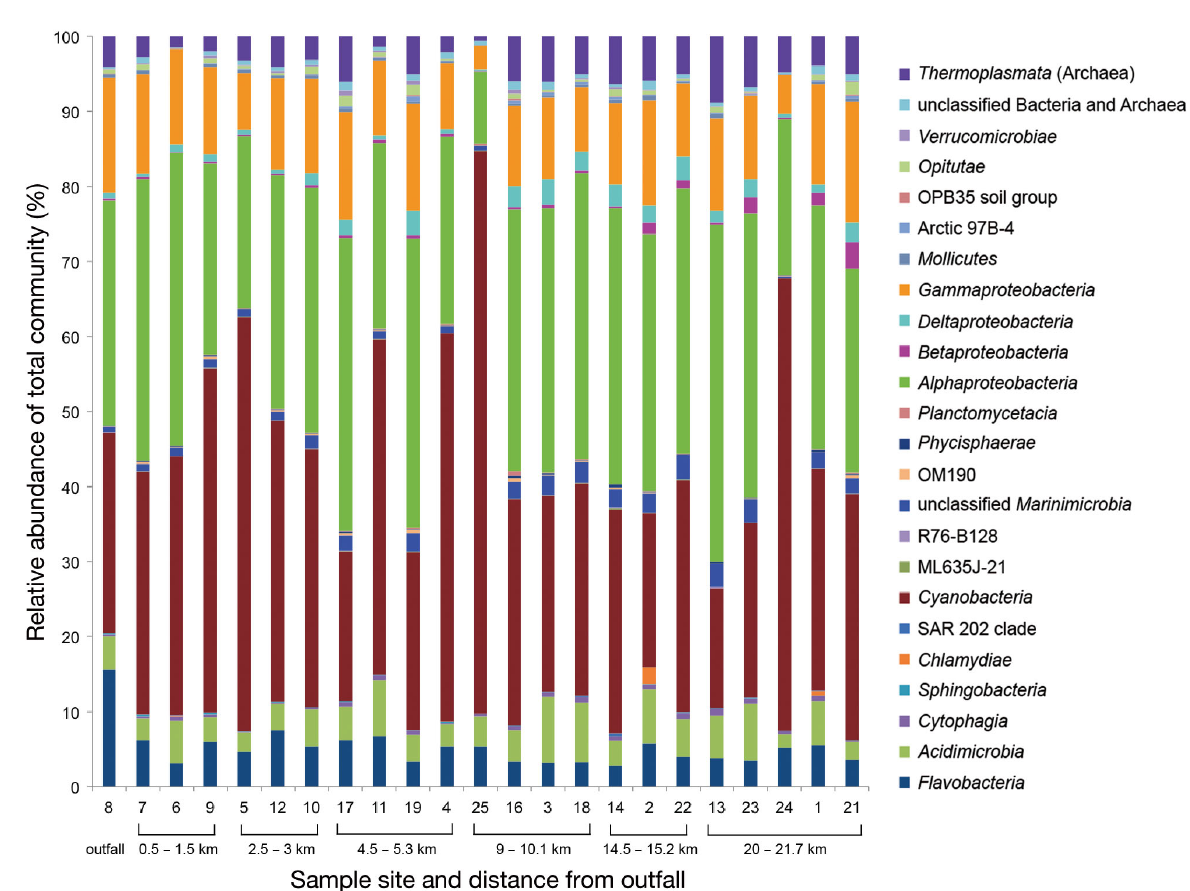
Fig. 4. Relative abundances of small subunit ribosomal RNA (SSU rRNA) gene sequences organized by taxonomic class for each site. Sites are organized by distance from outfall, with Sample 8 (outfall) on the far left and Sample 21 (21.7 km from Site 8) on the far right